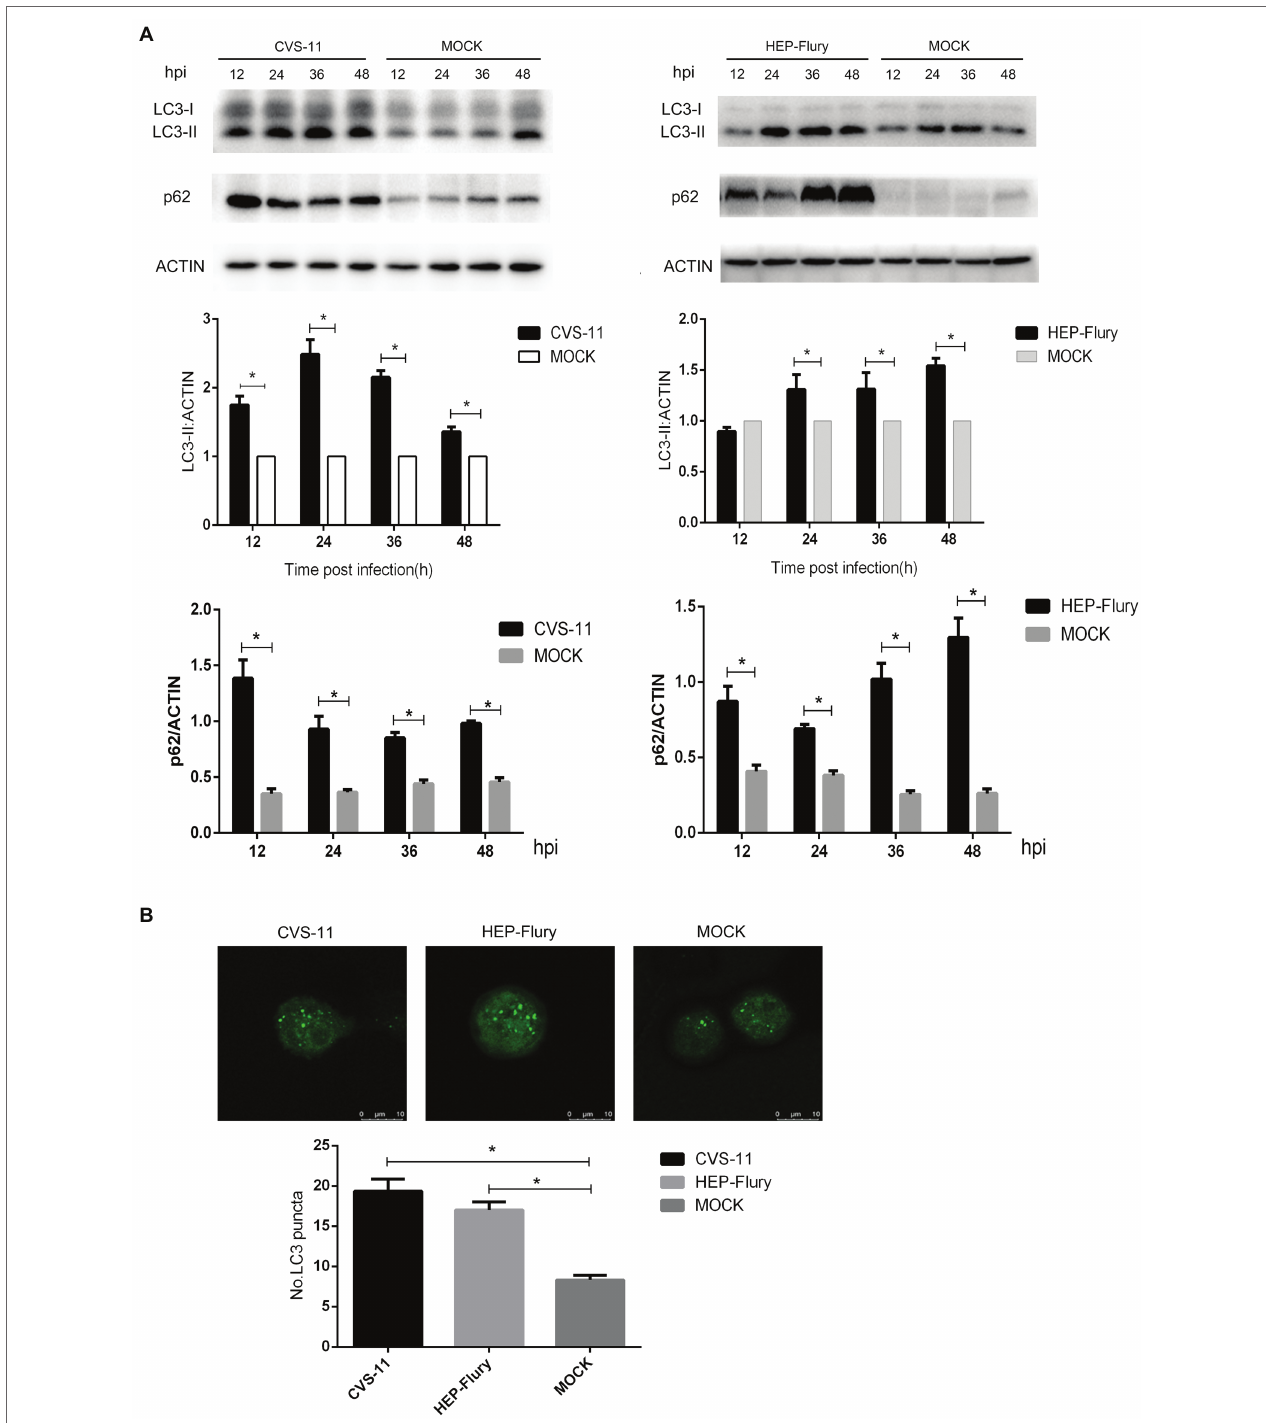
FIGURE 2 | Autophagy induced by RABV in BV2 cells. (A) Western blotting to analyze the expression of LC3 and p62 protein. BV2 cells were, respectively, infected with CVS-11 at an MOI of 10 or HEP-Flury at an MOI of 3. Cell lysates were harvested at 12, 24, 36, and 48 hpi. Western blot analysis was used to assess the relative expression levels of LC3-II, p62, and β -actin. Data are represented as mean ± SD, n = 3. Asterisks indicate significant differences between the groups calculated using a Student’s t -test (* p < 0.05). (B) LC3 dots in BV2 under laser confocal fluorescence microscopy. BV2 cells were transfected with plasmids and then infected with CVS-11 or HEP-Flury at an MOI of 3. The fluorescent dots in BV2 cells were directly observed at 12 hpi. The average number of LC3 dots was determined from at least 50 cells in each group. Data are represented as mean ± SD of three independent experiments. Asterisks indicate significant differences between the groups calculated using a Student’s t -test (* p <